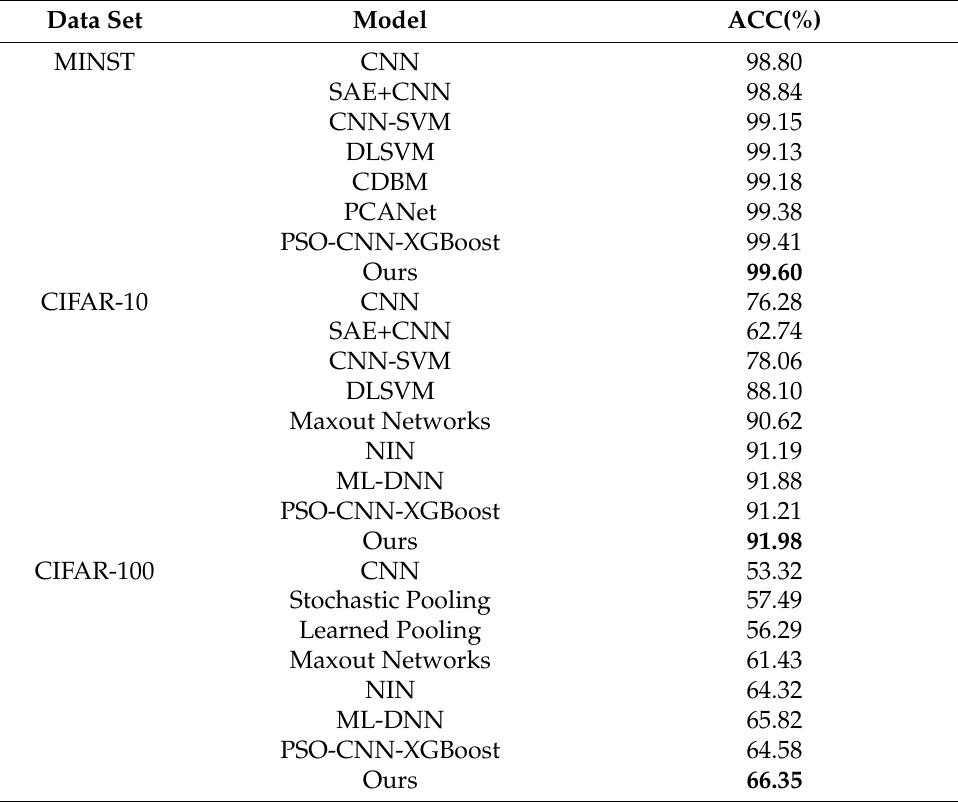
Table 4. Classification accuracy (%) on image set. Data